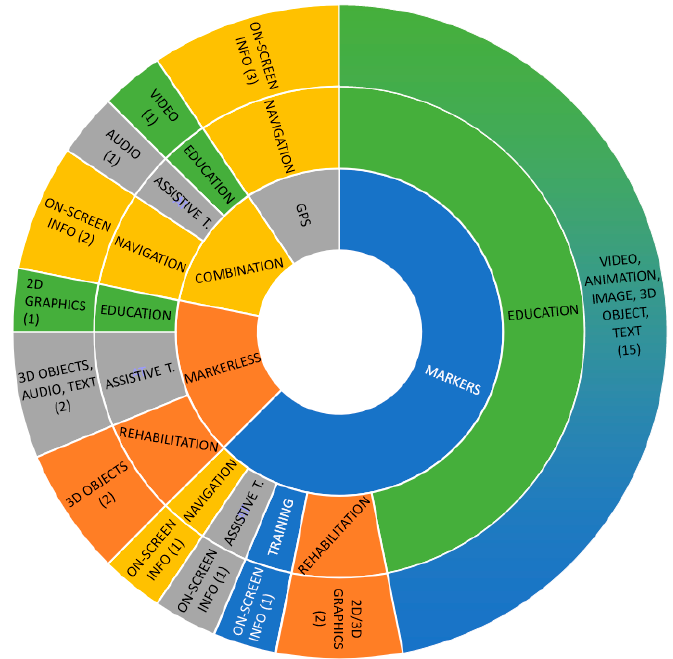
Figure 5. Distribution of AR solutions based on the primary AR virtual content used (the farthest circular wreath on the graph) and categorized by AR tracking technology type and application domain.